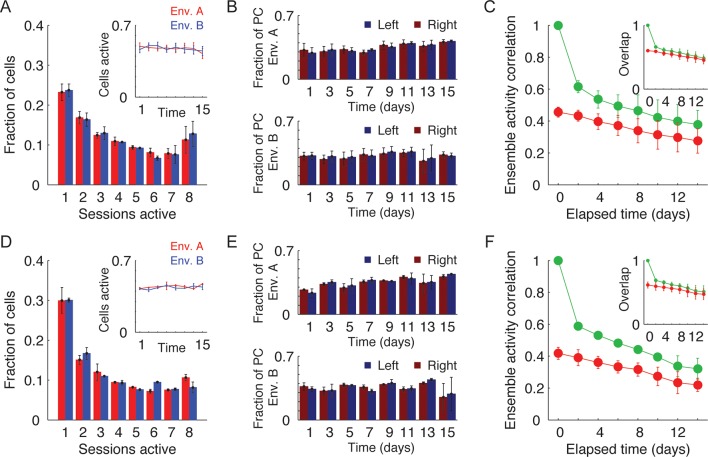
Activity and long-term dynamics of GCaMP6s- and GCaMP6f expressing cells.(A,D) Distribution of the total number of sessions in which cells were active for GCaMP6s (A) and GCaMP6f (D) (n=3, and n=2, respectively). Inset, the fraction of active cells detected in each session (red – environment A, blue – environment B). (B,E) Fraction of cells with significant place fields, expressed as the fraction of cells found in each session for each motion direction (top - environment A, bottom - environment B) for GCaMP6s (B) and GCaMP6f (E). (C,F) Correlations between cell activity patterns within the same environment (green data) or between different environments (red data) for GCaMP6s (C) and GCaMP6f (F). Ensemble activity correlations decay with elapsed time. Inset, the probability that a cell active on one day will be active on subsequent days in the same environment (green data) or in a different environment (red data). The recruitment probability decayed with elapsed time. Data are mean ± s.e.m.